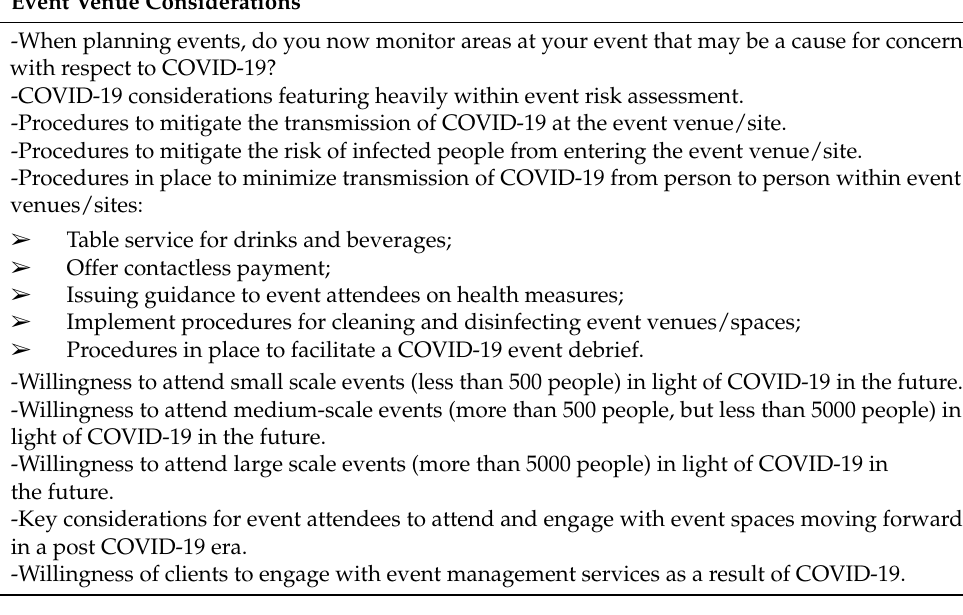
Table 1. Event venue